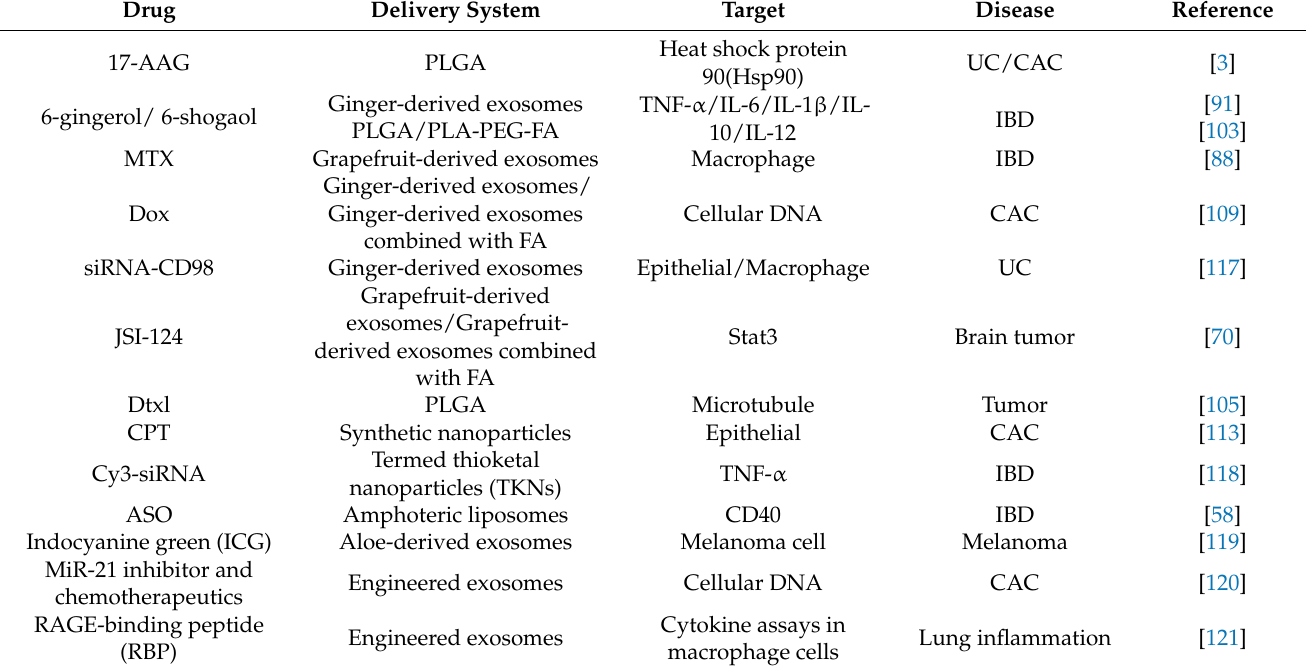
Table 1. Current delivery systems for disease